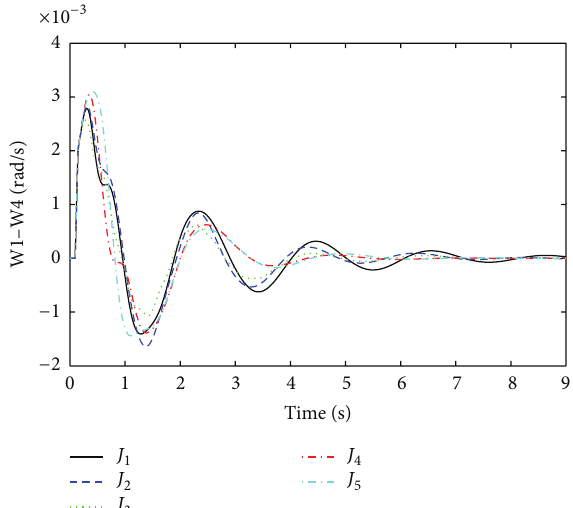
Figure 7: Local mode of oscillations between G1 and G2 (W1-W2) for three-phase fault at bus 13.